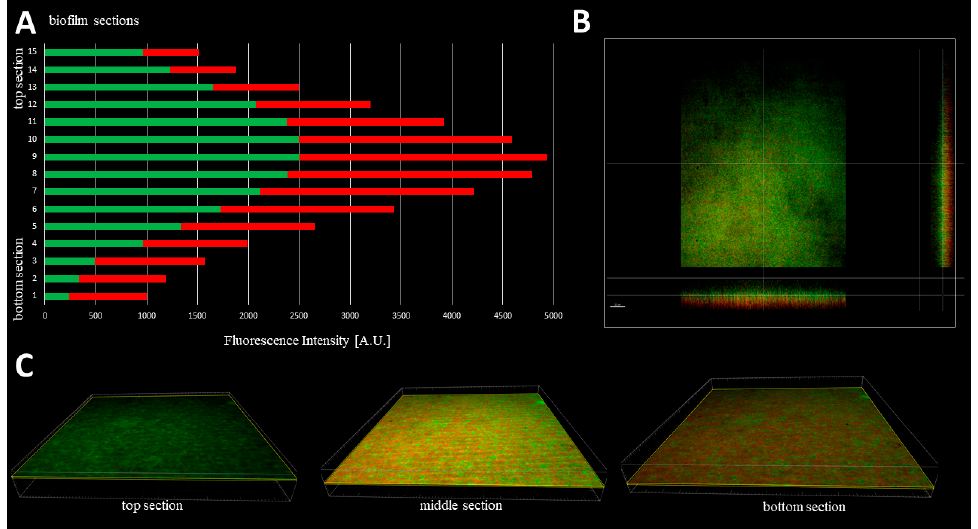
Figure 3. Typical distribution of cellular density through the biofilm (ATCC 6538 strain) from its top to the bottom section ( A , B ) and the growing share of dead/cell wall compromised cells in the deeper parts of biofilm ( A , C ). Thickness of every section was 2.16 µ m. Red and green color in ( A ) represents Fluorescence Intensity of propidium iodide or SYTO-9, respectively; microscope SP8, magnification 40×. Scale bar is 50 µm.